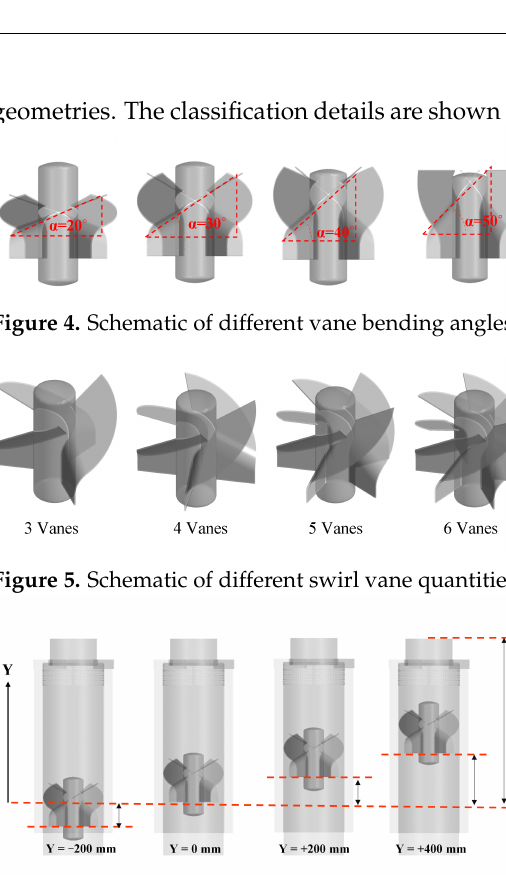
Figure 6. Schematic of the different swirl vane locations from the origin. Table 1. Summary of input